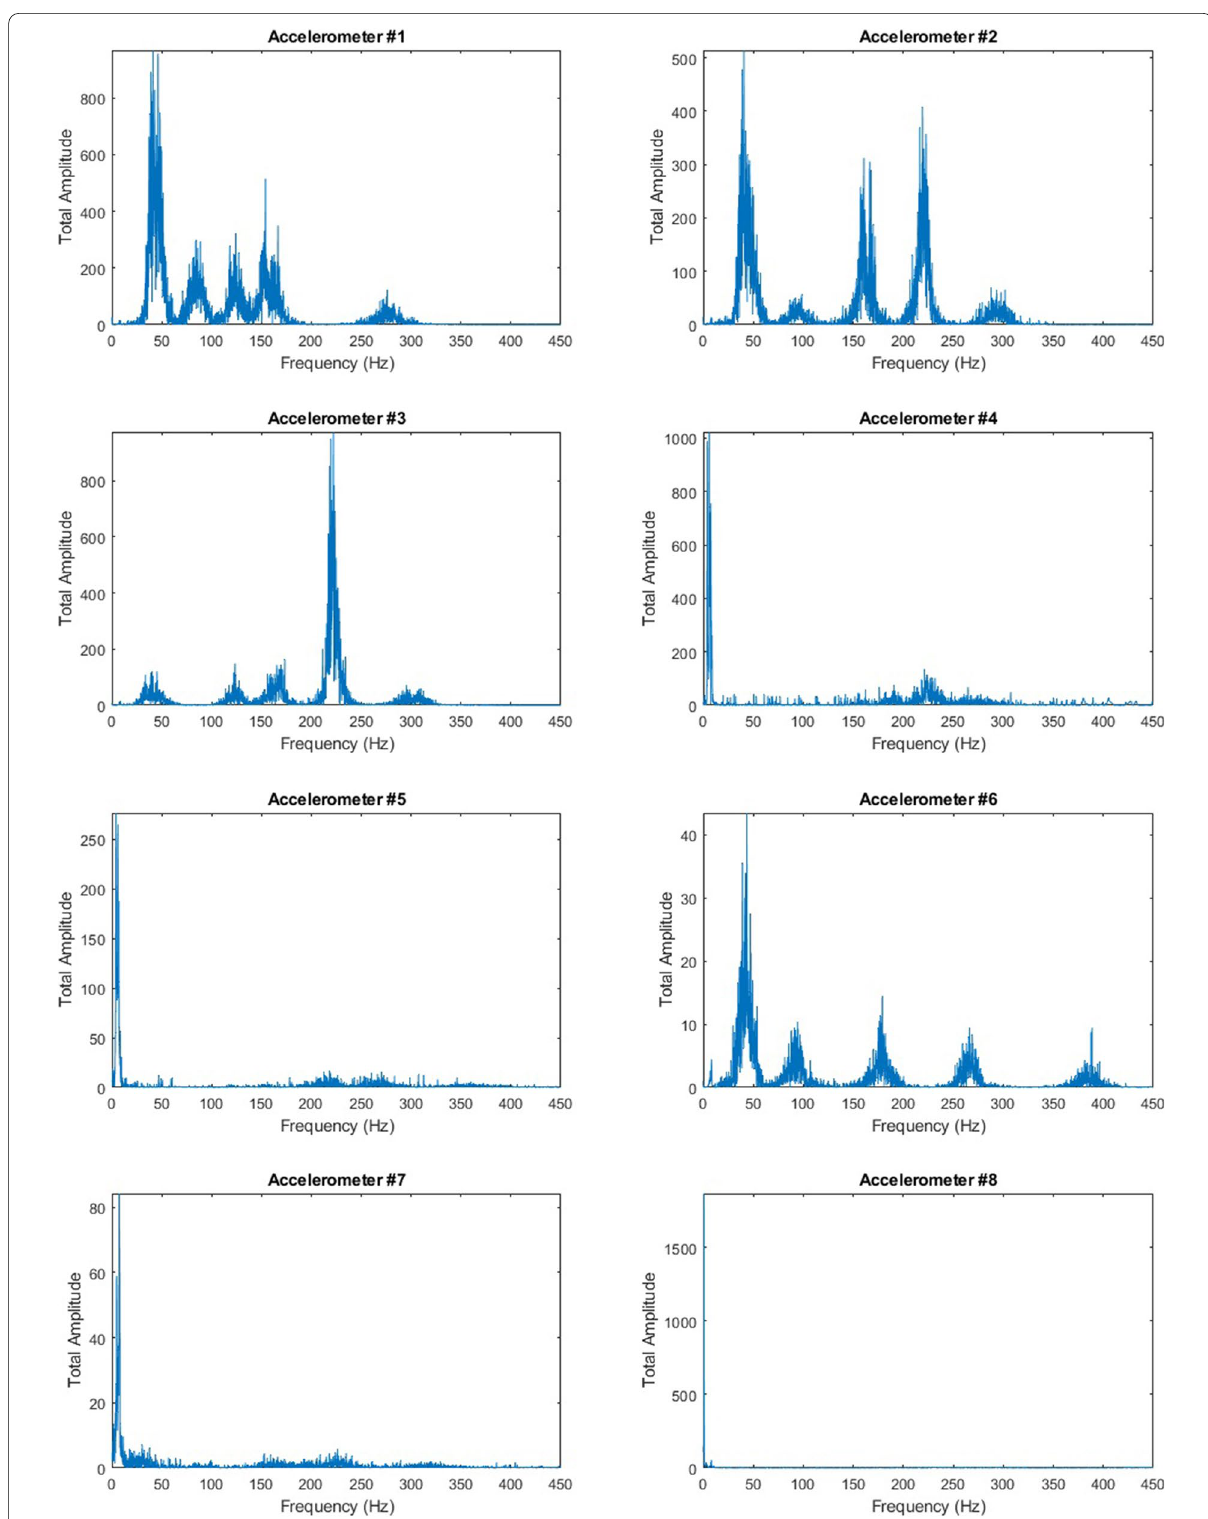
Fig. 8 Frequency spectrum along the height of the polycarbonate